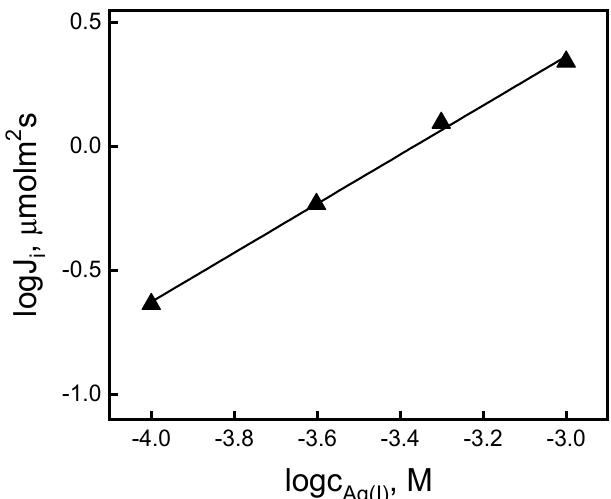
Figure 2. Logarithmic relationship of initial fluxes vs. Ag(I) concentration in the source aqueous phase. Source phase—various concentrations of AgNO 3 , pH = 4.0; membrane: 2.0 cm 3 o -NPPE/1.0 g CTA; 0.050 M KP, receiving phase: 0.10 M thiourea.